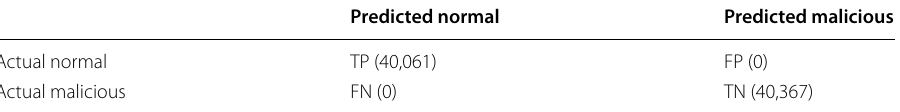
Table 18 Confusion matrix of Random Forest